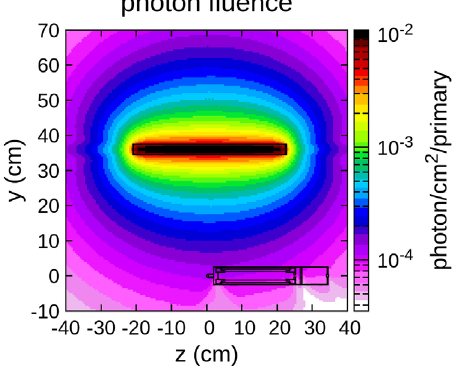
FIG. 12. The photon fluence map of 60 Co source. The distance of BLM to the source is 36 cm, and the fluence map is averaged over 5 cm.